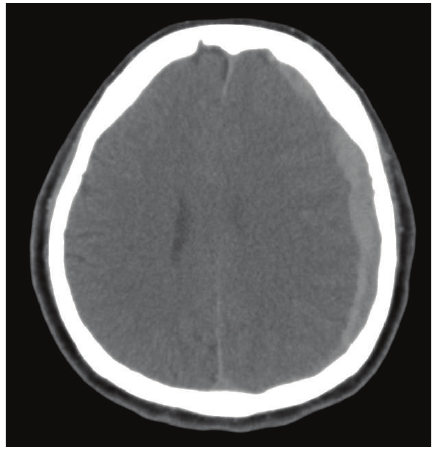
Figure 3: Brain CT (noncontrast), axial view. Subacute subdural hemorrhage was found after head trauma from a